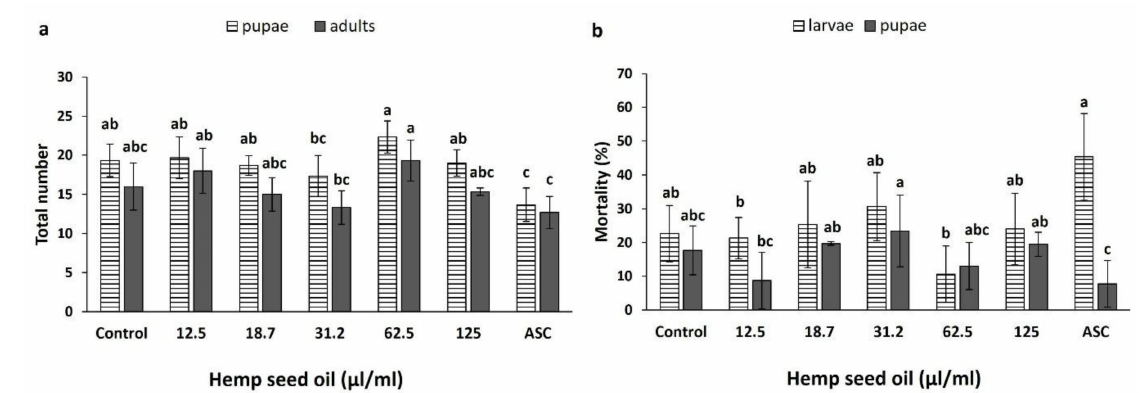
Figure 5. Effects of hemp seed oil and ascorbic acid on the total numbers of formed pupae and eclosed adults ( a ) and percentages of larval and pupal mortality ( b ). The larvae were exposed to six concentrations of the oil (0 (control), 12.5, 18.7, 31.2, 62.5, and 125 µ L/mL) and compared to a positive control of the antioxidant ascorbic acid (ASC). All values are expressed as means ± SD. Different letters above the means represent significant differences between treatments separately for larvae, pupae, or eclosed adults ( p < 0 05; LSD